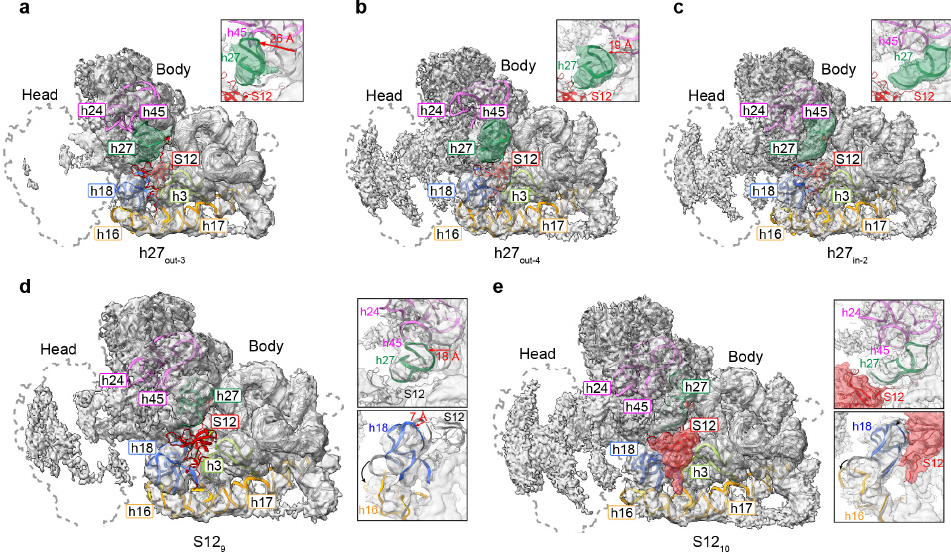
Figure 3. A low Mg 2+ concentration destabilizes the decoding center and causes a loss of S12 protein. ( a – c ) Three representative reconstructions were classified from 30S particles at 1 mM Mg 2+ by applying a mask to the decoding center. A completely out-shifted h27 (( a ), h27 out-3 ), a partially out-shifted h27 (( b ), h27 out-4 ), and h27 in its original position (( c ), h27 in-2 ), are represented in cartoon and surface (green) for their rigid-body-fitted structure and density map, respectively. ( d , e ) Two representative reconstructions with missing ( d ) and fully occupied S12 protein (( e ), red), were classified from 30S particles at 1 mM Mg 2+ by applying a mask to S12, as shown in the cartoon and on the surface. The rRNA helices h3 (limon), h16/h17 (yellow), h18 (blue), and h24/h45 (magenta) are also labeled according to the positions of the decoding center. Details of the interactions and movement (black arrows) of h27 and S12 are represented as inserted subfigures. A dashed line represents the mature 30S under 10 mM Mg 2+ conditions in this